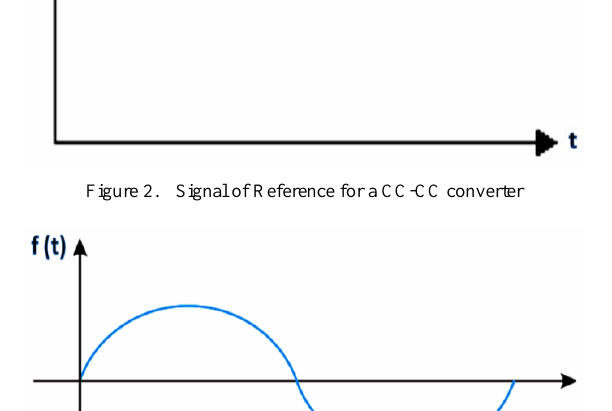
Figure 3. Signal of Reference for a CC-AC Converter